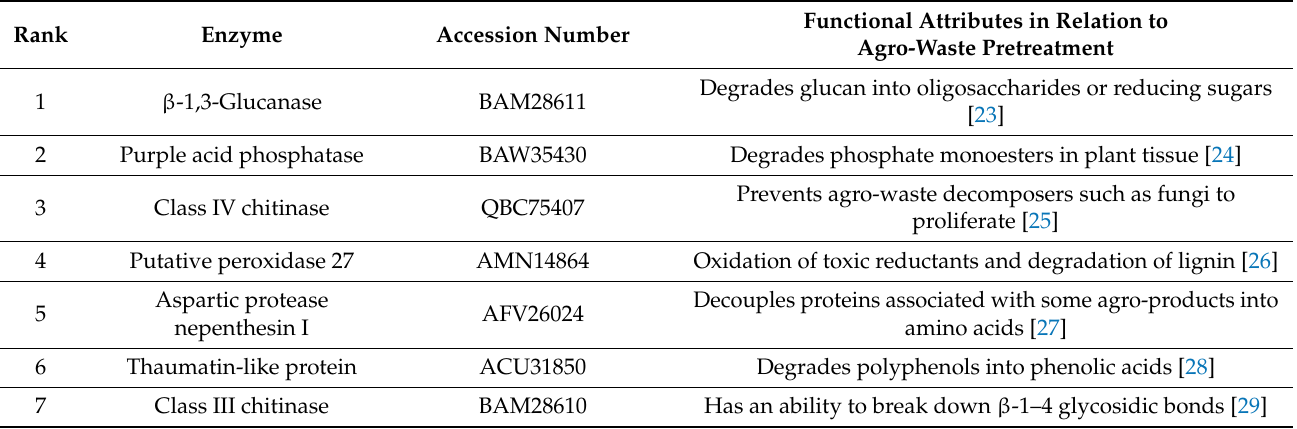
Table 3. Enzymes identified in the <10 kDa N. mirabilis pitcher fluid via a Byonic TM software search and their rankings based on the best